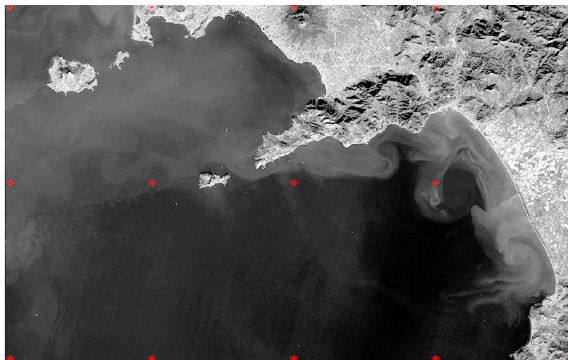
Fig. 3. CPs on the nautical chart